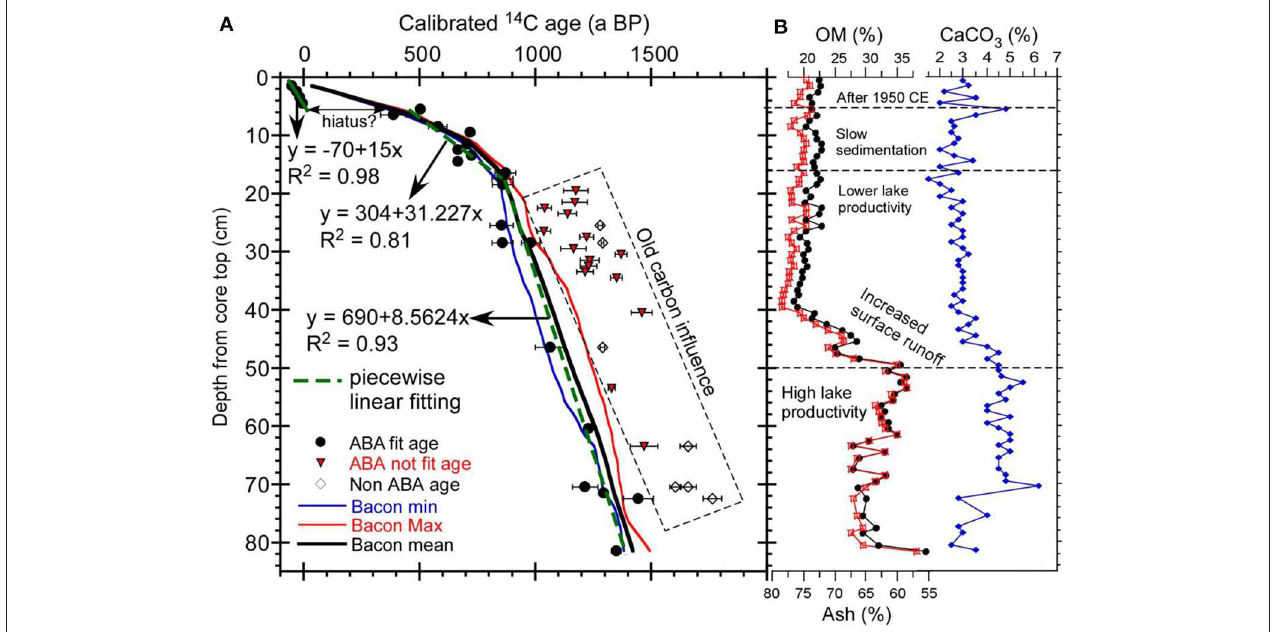
FIGURE 3 | (A) Accelerator mass spectrometry 14 C dating and chronology of the core. The three linear equations are used in available 14 C ages in three segments: 0–5, 6–20, and 20–82cm. (B) Organic matter (OM, black), ash (red), and CaCO 3 contents of the core. Note that the scale axis of OM and ash are opposite so that one can see the lake sediments that contain mainly OM and detritus, which are linearly negatively correlated ( R 2 =